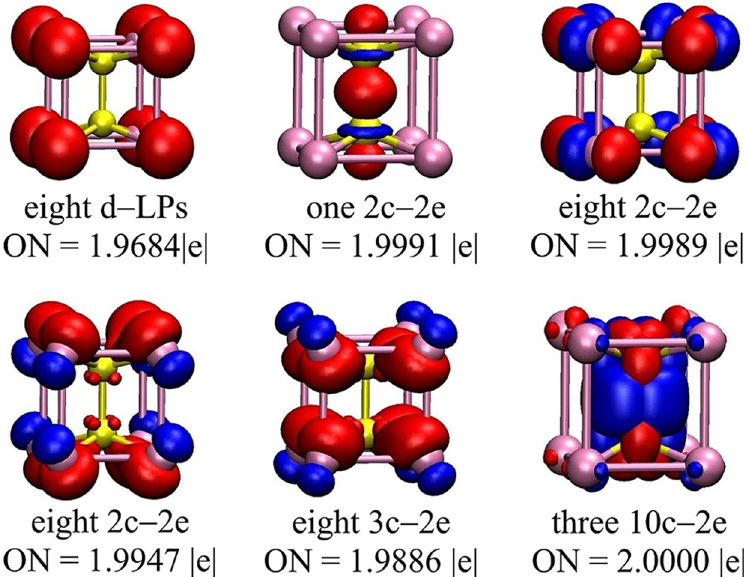
Figure 5. The results of AdNDP analysis for Re 2 Cl 82 − . ON represents the occupation